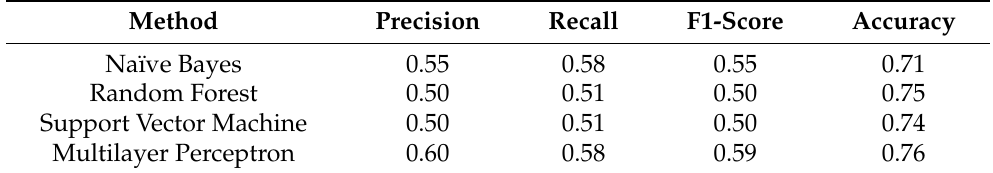
Table 2. Baseline evaluations with fastText embeddings in terms of precision, recall, and F1-score calculated as macro averages (the complete results are in Appendix